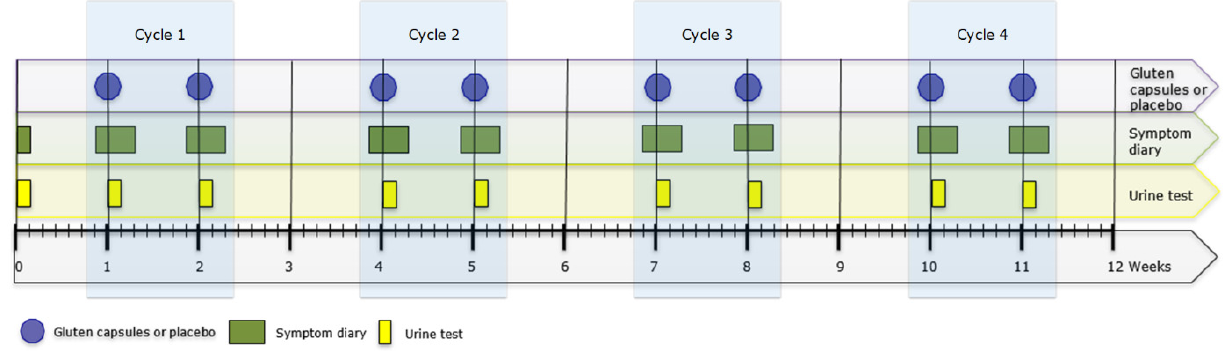
Figure 1. Study protocol flowchart.